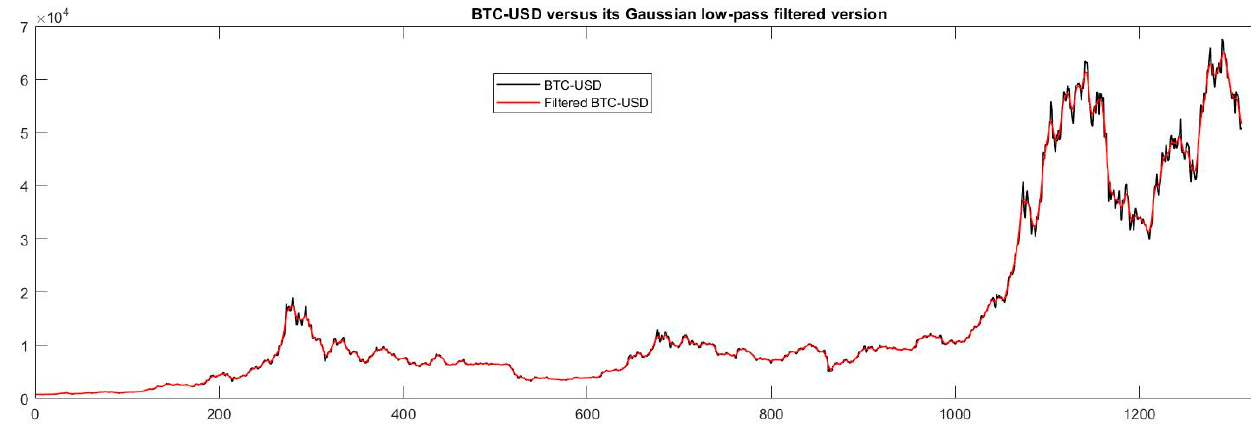
Figure 4. BTC–USD: PACF analysis.